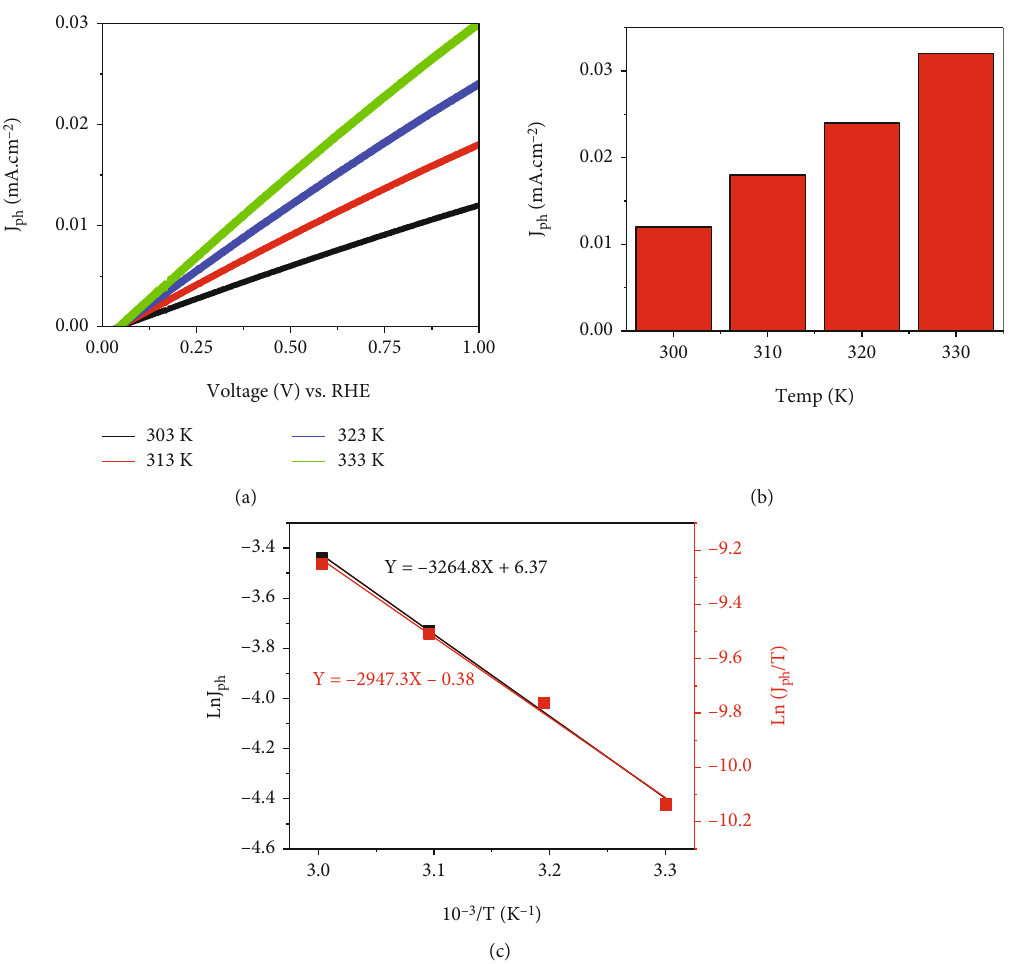
Figure 6: (a) The produced current density under di ff erent temperatures and (b) the produced current density at +1 V for the electrode glass/PANI/Ag O-Ag II. (c) The Arrhenius (black curve) and Eyring equation (red curve) relationship for calculation of the 2 thermodynamic